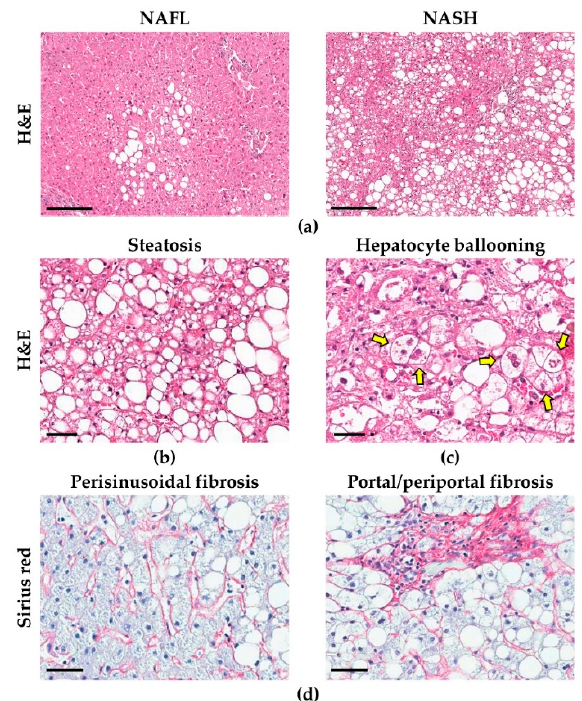
Figure 1. Histo-morphological features of non-alcoholic fatty liver disease (NAFLD). The progression from simple steatosis (non-alcoholic fatty liver—NAFL) to non-alcoholic steatohepatitis (NASH) ( a ) is characterized by increased hepatic steatosis ( b ) and inflammation, accompanied by the emergence of specific histological features, such as hepatocellular ballooning (arrows in c ). As disease advances, liver fibrosis develops ( d ). H&E: hematoxylin and eosin; scale bars: 200 ( a ), 50 ( b , c ) and 100 μ m ( d ). Images obtained from liver biopsies of patients affected by NAFLD.